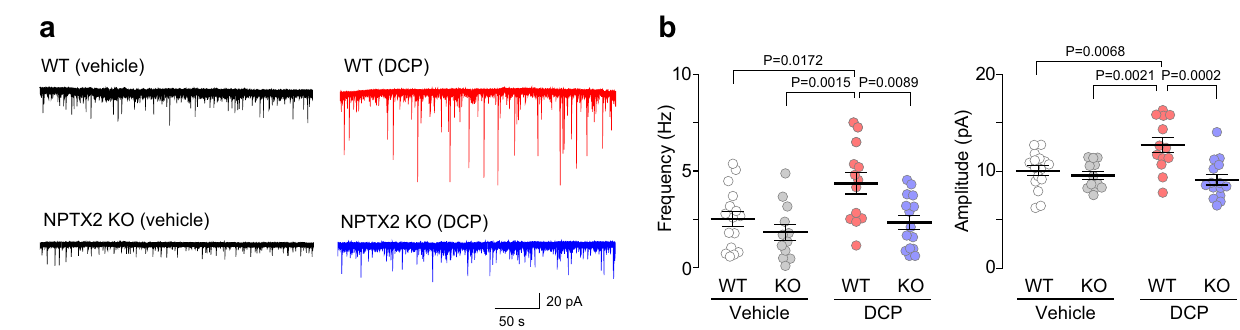
Fig. 3 NPTX2 is indispensable for excitatory synaptic facilitation in GRPR + SDH neurons in chronic itch model. a , b Representative traces ( a ) and the frequency and amplitude ( b ) of sEPSCs in cervical spinal cord slices from vehicle- or DCP-treated WT and NPTX2 KO mice (vehicle: WT, n = 16 cells; KO, n = 12 cells; DCP: WT, n = 13 cells; KO, n = 15 cells; one-way ANOVA with post hoc Tukey ’ s multiple comparisons test). Values represent mean ± S.E.M. Source data are provided as a Source Data fi le.